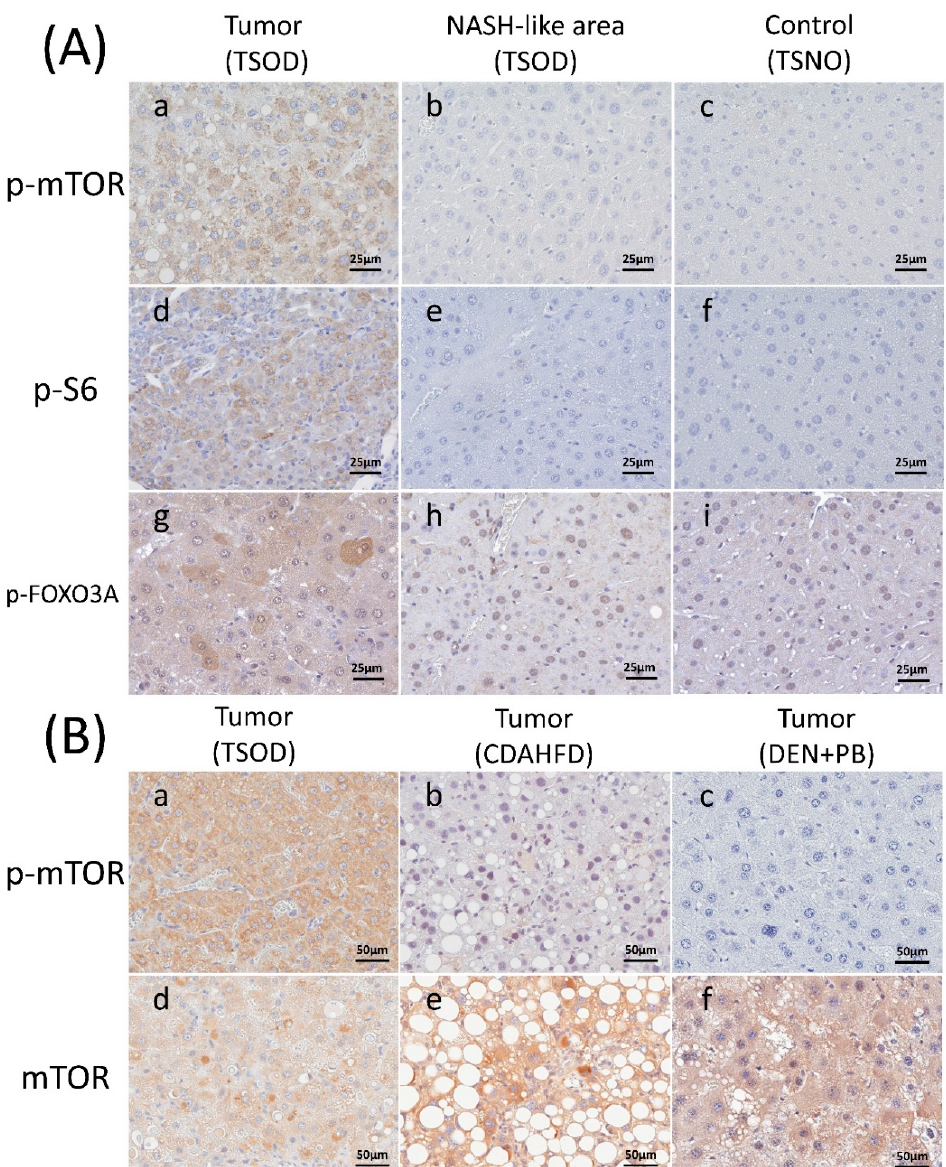
Figure 2. Representative immunohistochemical findings of NASH model mice. ( A ) p-mTOR, p-S6 and p-FOXO3A in liver tumors and liver tissues of TSOD mice and liver tissues of TSNO mice. Immunohistochemistry of p-mTOR in the liver tumor of TSOD mouse ( a ), surrounding NASH-like area of TSOD mouse ( b ) and control normal liver tissue of TSNO mouse ( c ), p-S6 in the liver tumor of TSOD mouse ( d ), surrounding liver tissue of TSOD mouse ( e ) and control normal liver tissue of TSNO mouse ( f ) and p-FOXO3A in the liver tumor of TSOD mouse ( g ), surrounding liver tissue of TSOD mouse ( h ) and control normal liver tissue of TSNO mouse ( i ). Note that p-mTOR, p-S6, and p-FOXO3A are strongly expressed in liver tumors of TSOD mice. ( B ) mTOR and p-mTOR in liver tumors of TSOD, CDAHFD-fed C57BL/6J mice and B6C3F1 mice given diethylnitrosamine (DEN) and phenobarbital (PB). Immunohistochemistry of p-mTOR in liver tumors of TSOD mice ( a ), mice given CDAHFD ( b ) and mice given DEN and PB ( c ) and mTOR in liver tumors of TSOD mice ( d ), mice given CDAHFD ( e ) and mice given DEN and PB ( f ). Note that p-mTOR was characteristically expressed in liver tumors of TSOD mice. Scale bar: 25 µ m ( A ( a – i )), 50 µ m ( B ( a – f )). NASH: Non-alcoholic steatohepatitis; DEN: diethylnitrosamine; PB: phenobarbital; TSOD: Tsumura Suzuki obese diabetes; TSNO: Tsumura Suzuki non-obesity; CDAHFD: choline-deficient, L-amino acid-defined, high-fat